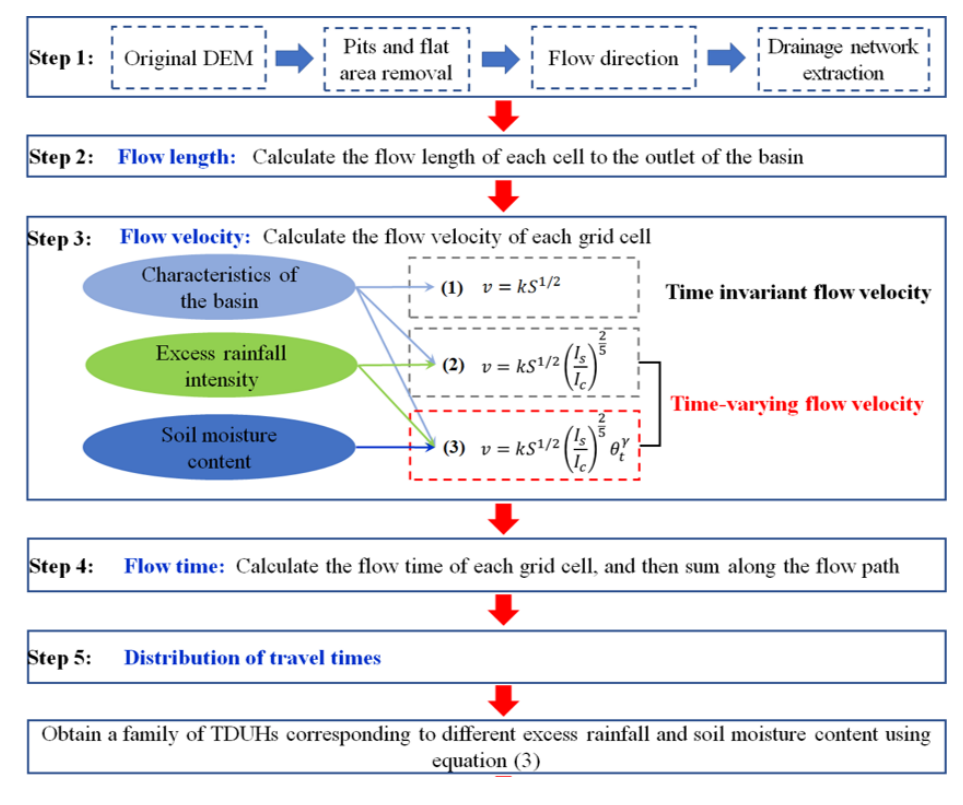
Figure 2. Schematic diagram of the DUH method considering time-varying rainfall intensity and soil moisture content, in which Eqs. (1), (2) and (3) are the time-invariant flow velocity, time-varying flow velocity considering excess rainfall intensity and time-varying flow velocity considering both excess rainfall intensity and soil moisture content. The unit hydrograph derived from the three flow velocity equations corresponds to DUH, TDUH and the TDUH-MC method